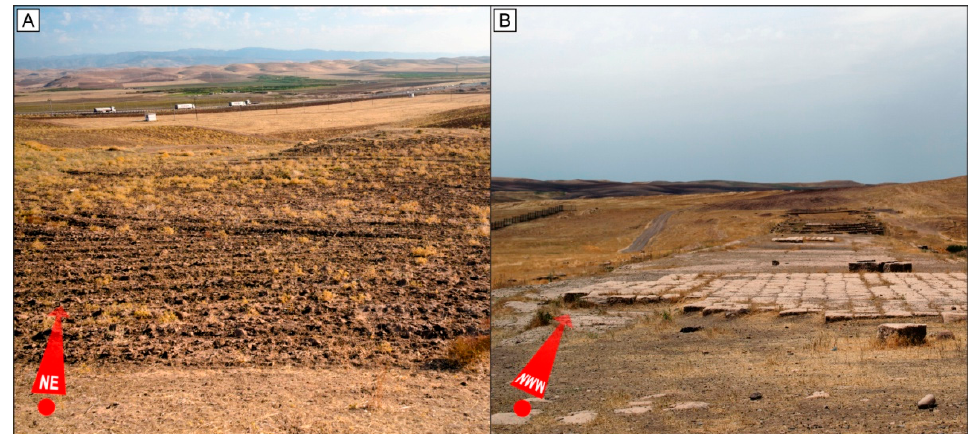
Figure 14. Image of a stretch of the Assyrian canal: ( A ) near the city of Mahad (© Gaugamela Project) and ( B ) at Jerwan (courtesy of Levi Meir Clancy). For a wider context of this location, see Figure 15.